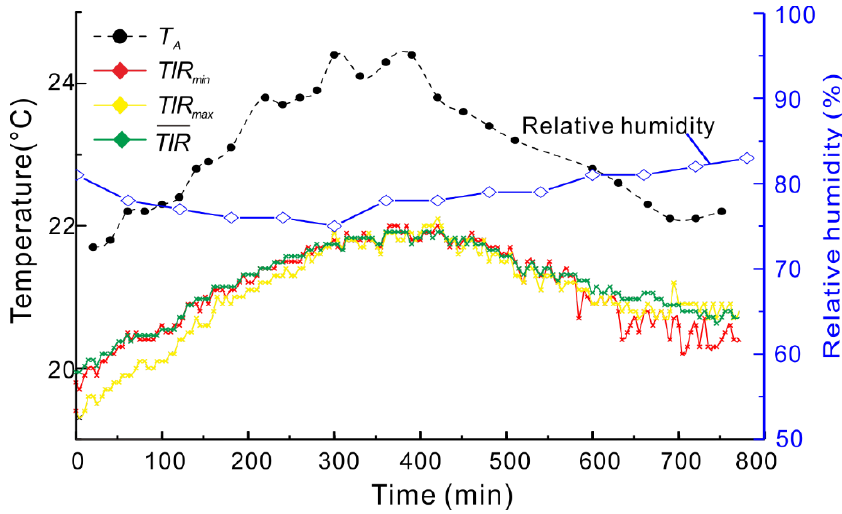
Figure 5. 3M index of the study zone B2 and ambient temperature ( T A ) and relative humidity versus time. TIR min , TIR max , TIR is the minimum, maximum, and average value of temperature for the study region.